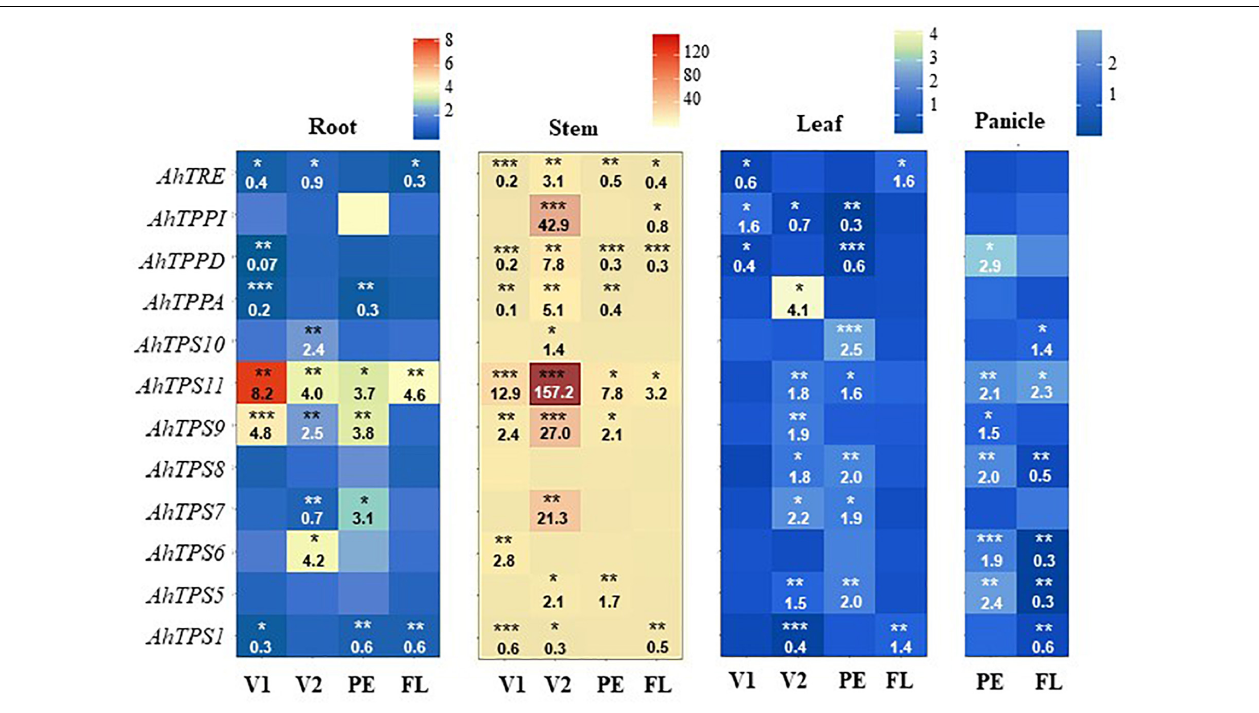
FIGURE 4 | Changes in the expression of trehalose metabolism genes in defoliated versus non-defoliated Amaranthus cruentus plants. Data shown compare completely defoliated versus intact A. cruentus plants at four different developmental stages: vegetative 1 (V1), vegetative 2 (V2), panicle emergence (PE), and flowering (FL). RNA was extracted for each stage from the following tissues: roots, stems, leaves, and panicles. qRT-PCR was then performed for genes coding for enzymes involved in trehalose-6-phosphate (Tre6) synthesis (trehalose phosphate synthase, TPS class I: AhTPS1 ), signaling (TPS, class II: AhTPS5-11 ), Tre6P de-phosphorylation (trehalose phosphate phosphatase, TPP: AhTPPA , D and I ), and trehalose degradation (trehalase, TRE, AhTRE ). Relative expression was quantified based on the 2 − (cid:49)(cid:49) CT calculation (Livak and Schmittgen, 2001). C T values for all genes were normalized to the C T value of the AhACT7 and AhEF1a housekeeping genes. Then, the changes in gene expression were calculated from four technical replicates. Asterisks indicate statistically significant differences with undefoliated controls: * P < 0.05, ** P < 0.01, or *** P < 0.001 ( n = 4) for a one-way ANOVA, Tukey HSD test. Data shown are representative of an experiment that was replicated twice. Changes are visualized using a different color code for each tissue, as indicated in the upper section of the